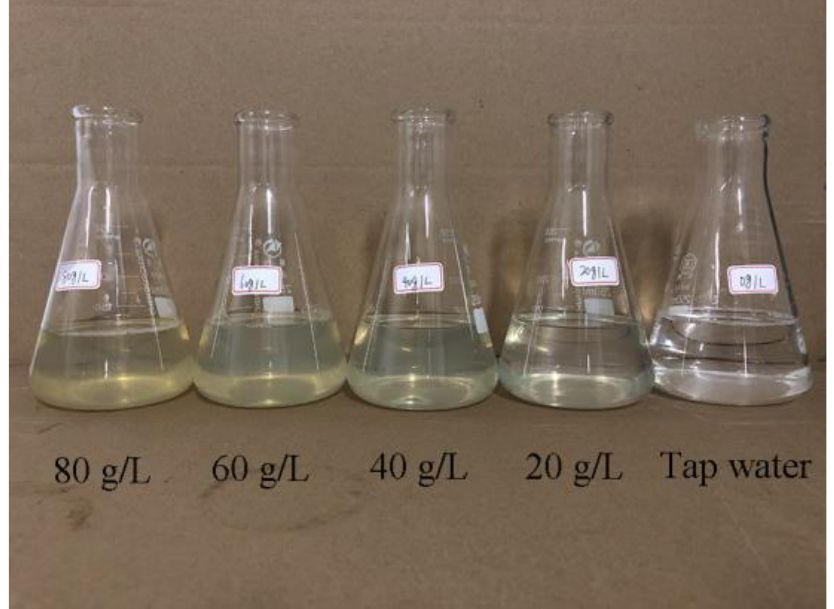
Figure 2. Soybean crude urease used in this study. Poorly-graded Ottawa sand [20] with a mean size of 0.36 mm was used throughout this study. Table 1 summarizes the physical properties of the tested sand. Polyvinyl chloride (PVC) cylindrical molds were employed to make the sand specimens (diameter = 50 mm, length = 100 mm). Dry sand was placed into each mold at a rela- tive density of ~45% by pluviation. Each column was positioned vertically with top and bottom open. A low-temperature premixed percolation method was used in this study to bio-stabilize the sand. Biological reagents (soybean crude urease and cementation solution) with a low temperature (4 ◦ C) were firstly premixed and then immediately introduced to the sand by surface percolation (from the top). The infiltration of liquid was due to the gravity and capillary forces. The low-temperature premixed method’s key feature was that the urease activity could be temporarily suppressed (see Figure 3) during the infiltration phase, thus inhibiting the fast accumulation of CaCO 3 precipitation in the surficial soil. Under surface percolation (fully drained) conditions, the water retention capacity of Ottawa sand in the columns was ~72 mL. The retained water was characterized as capillary water and adsorbed water [21]. The low-temperature premixed percolation process consisted of